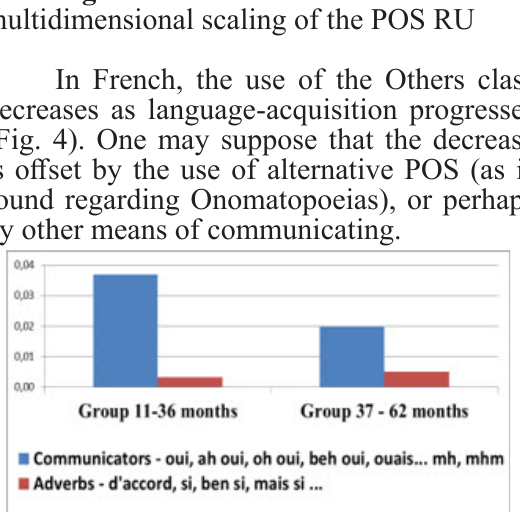
Figure 7. Example - use of some affir - mative communicators and adverbs in